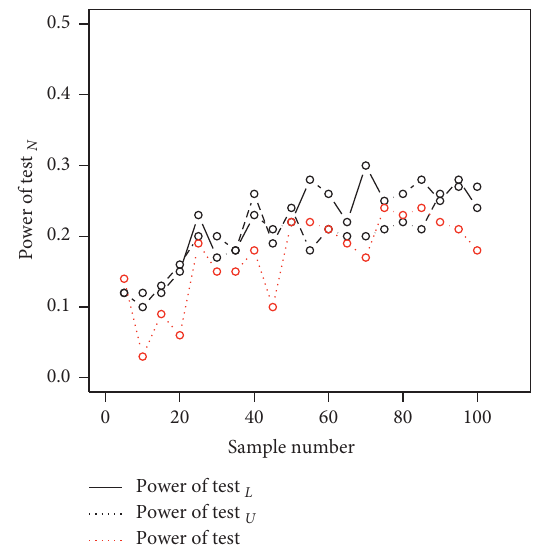
Figure 7: Comparison of the proposed test and the existing test for neutrosophic chi-square distribution.